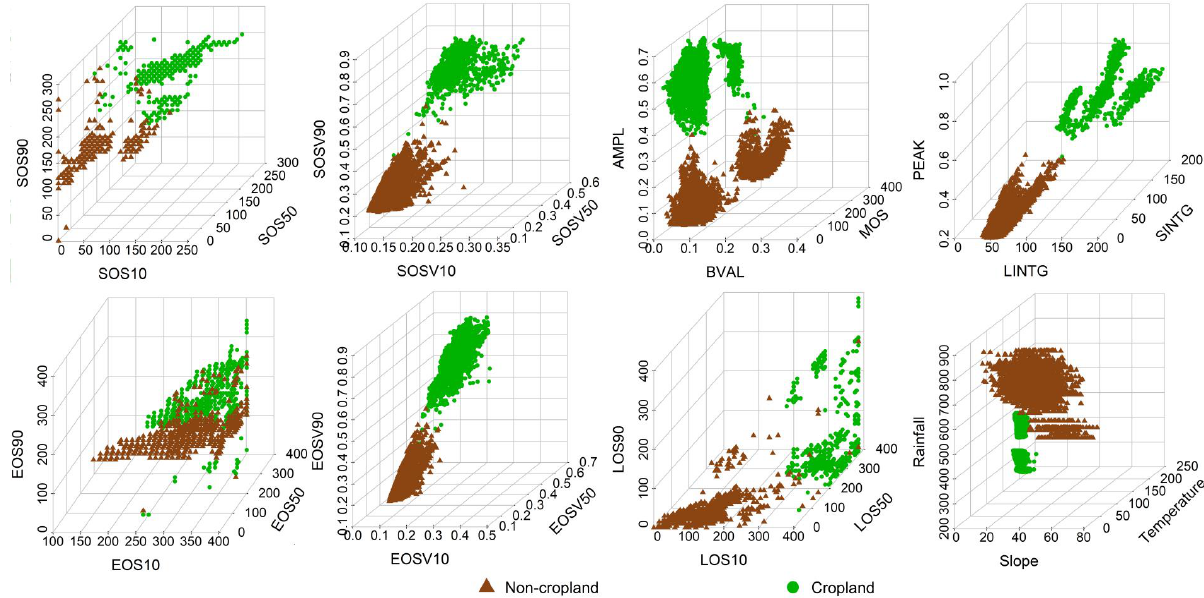
Figure 10. 3D-scatterplots illustrating the input features (phenology, co-environmental) differences between croplands versus non-croplands. This knowledge is used in the random forest algorithm to classify cropland versus non-croplands. The DOY (Day of Year) of SOS and EOS begins on the 1 September of each year.